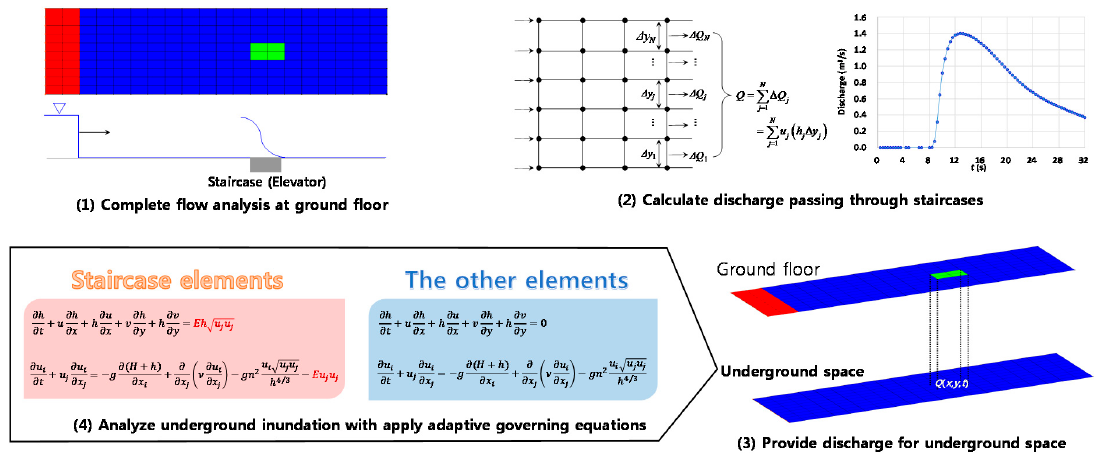
Figure 2. Representation of the ATM.